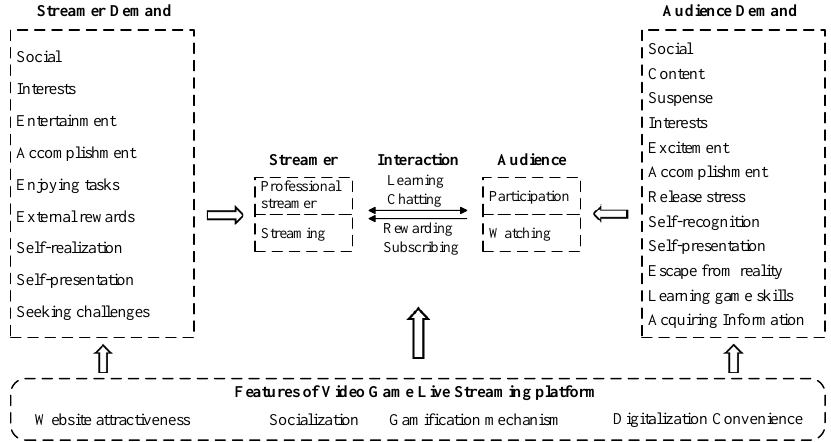
Figure 2. The research framework of video game live streaming. Source: Compiled by the authors.